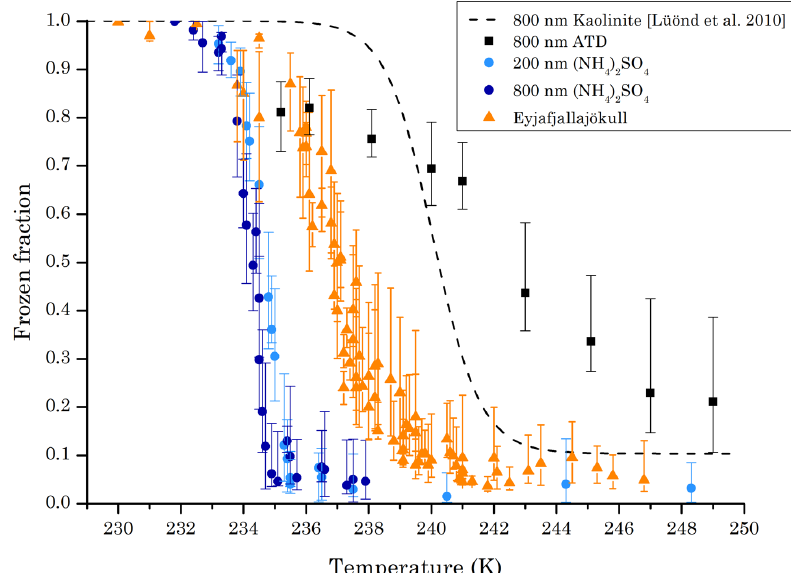
Fig. 5. Immersion freezing of droplets as a function of temperature, from IMCA/ZINC measurements. Orange triangles: fraction of ash par- ticles which nucleated ice, as a function of temperature. Blue points: frozen fraction for homogeneous nucleation of cloud droplets produced by CCN activation of ammonium sulphate particles with dry diameters of 200nm (light blue) and 800nm (dark blue). For comparison, data for ATD and 800nm kaolinite particles are also